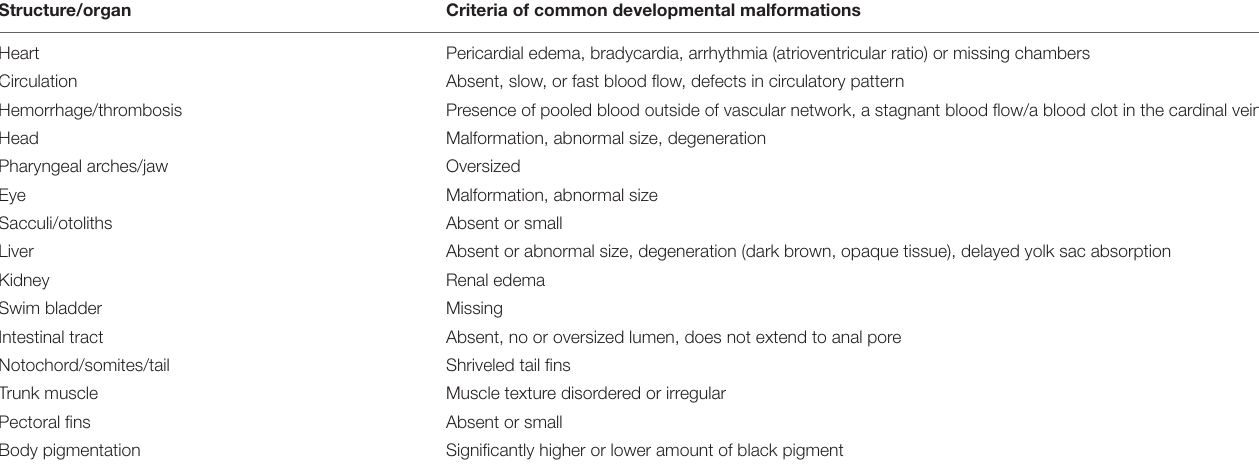
TABLE 2 | Developmental malformations observed in zebrafish. Structure/organ Criteria of common developmental